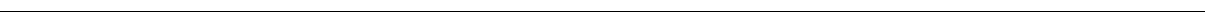
Fig. 2 γ 2 AMPK activation lowers intrinsic HR by downregulating SA cell I f and Ca 2+ clock pacemaker mechanisms. a HR in beats per minute (bpm) of R299Q γ 2 and WT mice under anesthesia ( n = 7 – 12). b HR during ex vivo-isolated cardiac perfusion ( n = 6 – 11). c Representative action potentials from SA cells isolated from R299Q γ 2 and WT mice. d Mean beating rate of SA cells from groups illustrated in c ( n = 17 cells). e qRT-PCR validation of differentially expressed genes on SA node microarray ( n = 3). FC fold-change. f , g Representative western blot ( f ) and analysis ( g ) of HCN4 levels in SA nodes